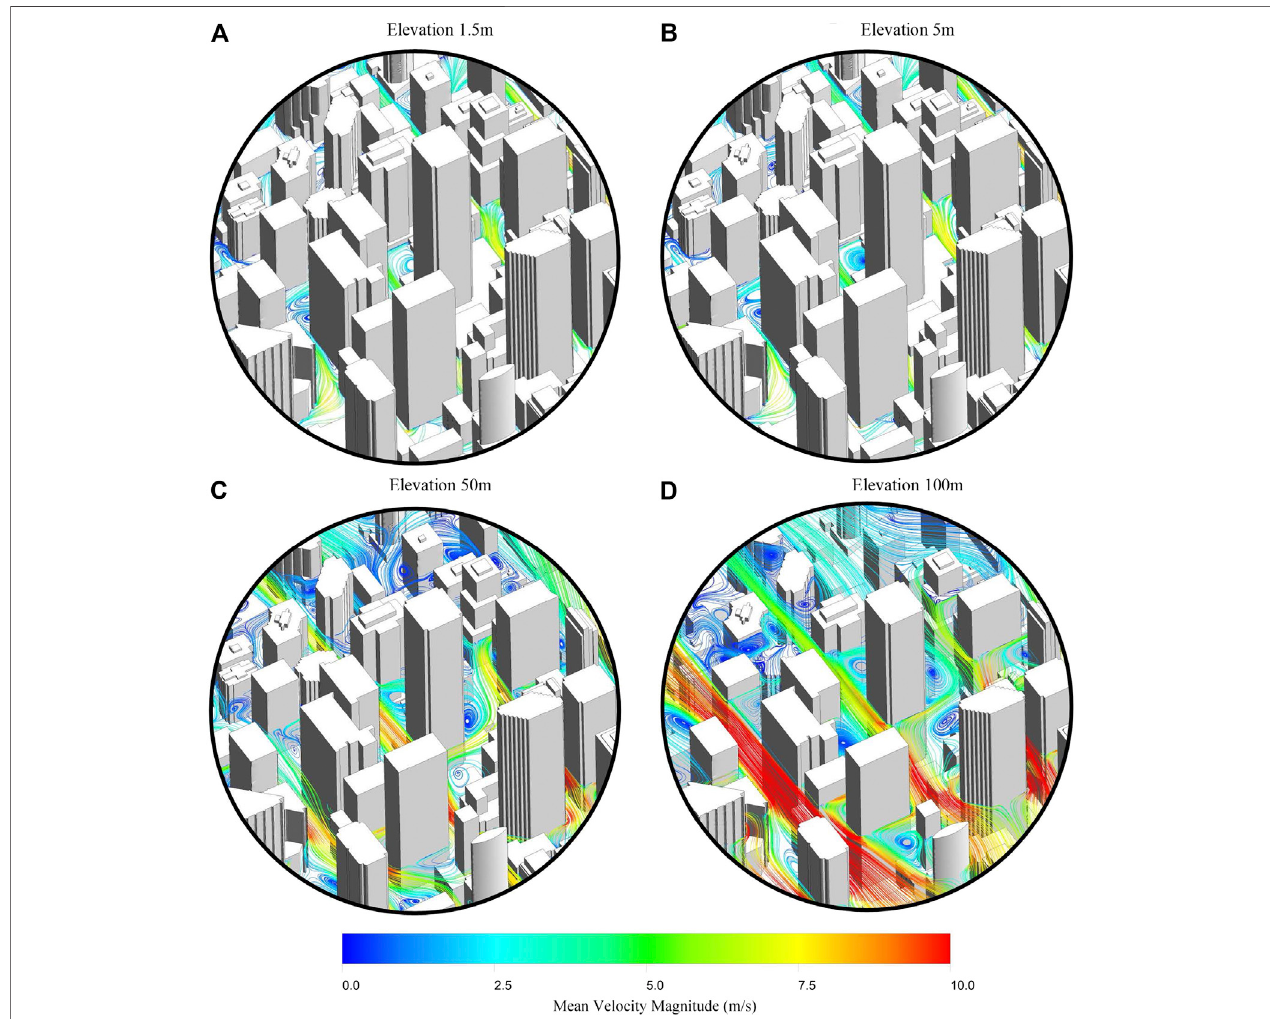
FIGURE 9 | 50G_North3 Velocity Streamlines at different